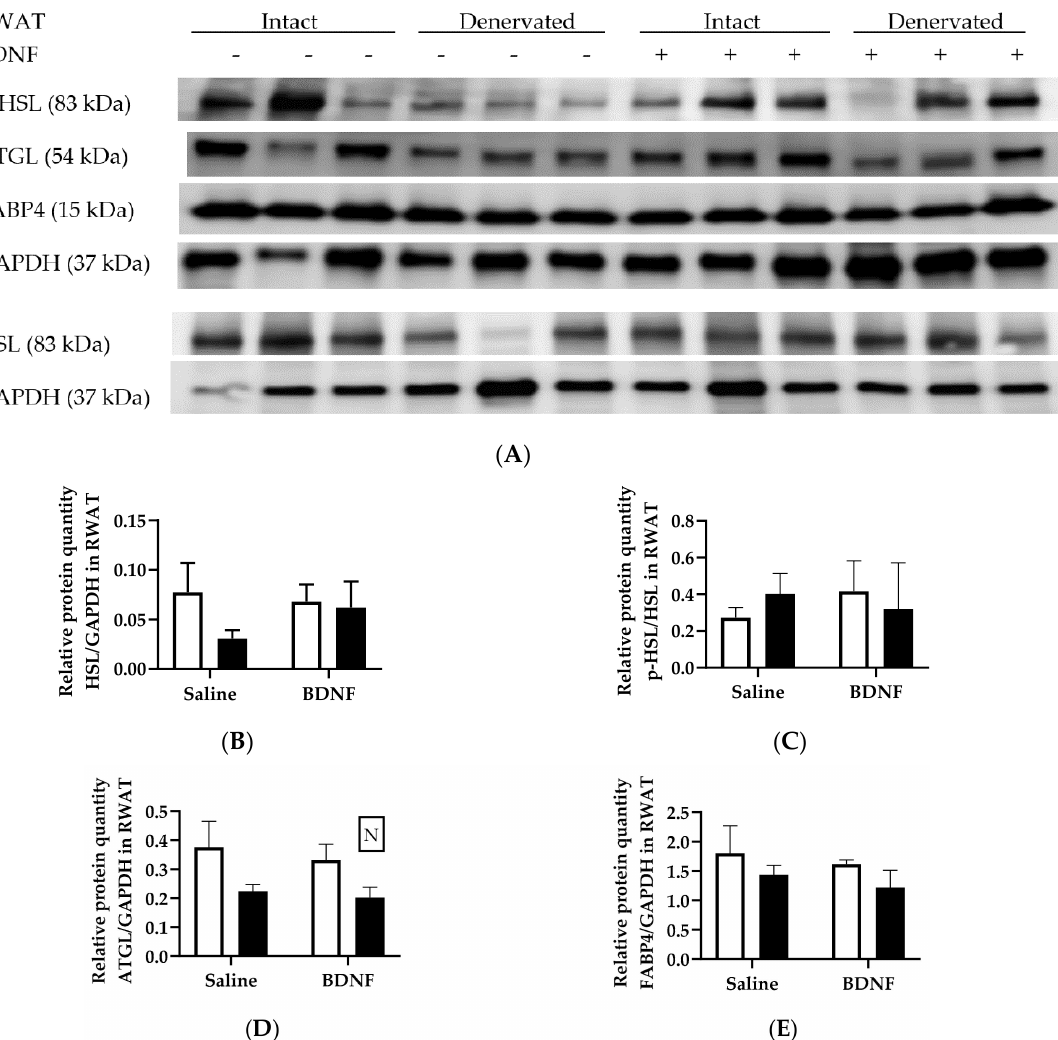
Figure 6. Expression of lipolytic p-HSL, HSL, ATGL, and FABP4 in intact and denervated retroperitoneal